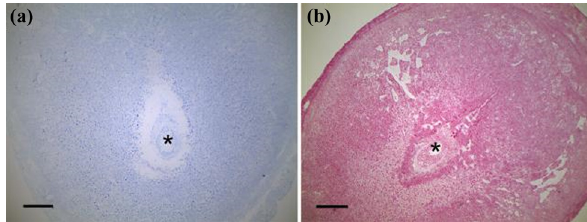
Figure 6: Mouse uteri of early pregnancy on day 8 stained with TB ( a ) and XP ( b ) . * = embryo. 100 × fi nal magni fi cation. Bar = 60